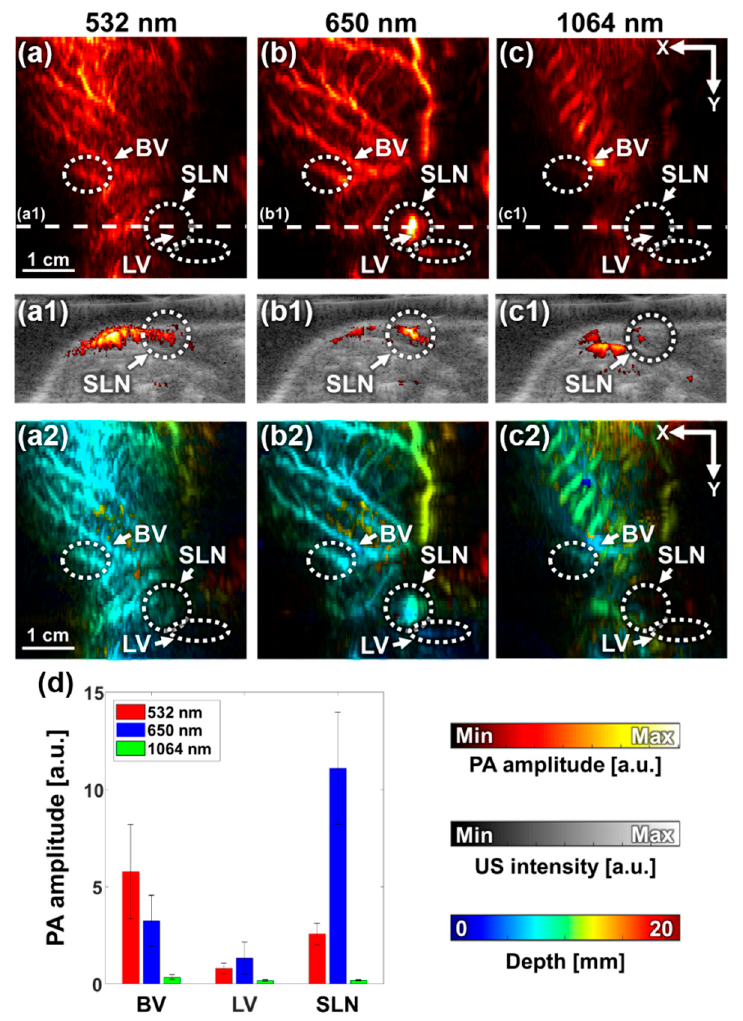
Figure 6. In vivo multispectral PA imaging of rat sentinel lymph node. ( a–c ) PA MAP images obtained with 532-, 650-, and 1064-nm wavelengths, respectively. ( a1–c1 ) Cross-sectional B-mode PA/US images at white, dashed lines in Figures ( a–c ), respectively. ( a2–c2 ) Depth-encoded PA MAP images. ( d ) Quantified PA amplitudes at BV, LV, and SLN with different wavelengths. PA, photoacoustic; BV, blood vessel, LV, lymph vessel; SLN, sentinel lymph node; and a.u., arbitrary unit.